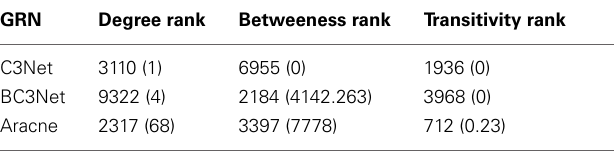
Table 6 | MYC rank (in decreasing order) for degree centrality, betweeness and transitivity for the C3Net, BC3Net, and Aracne